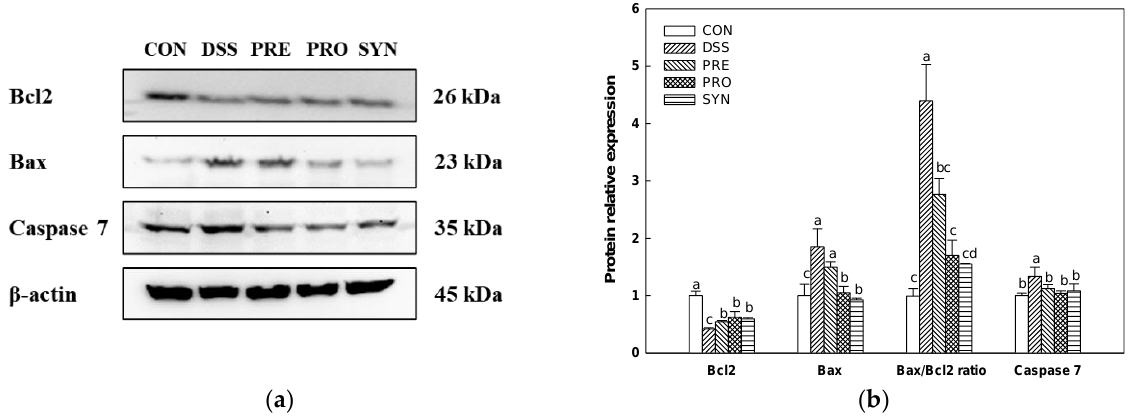
2.10. Effect of PRE, PRO, and SYN on Apoptosis Pathway in Brain Tissue 268